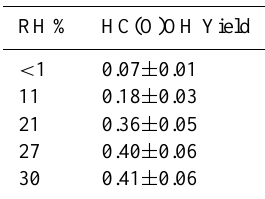
cally derived modelled trend line for ethene ozonolysis under RH